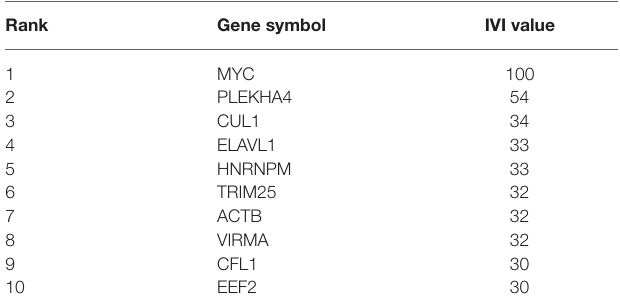
TABLE 2 | The top 10 influential network nodes according to IVI value analyzed by IVI. Rank Gene symbol